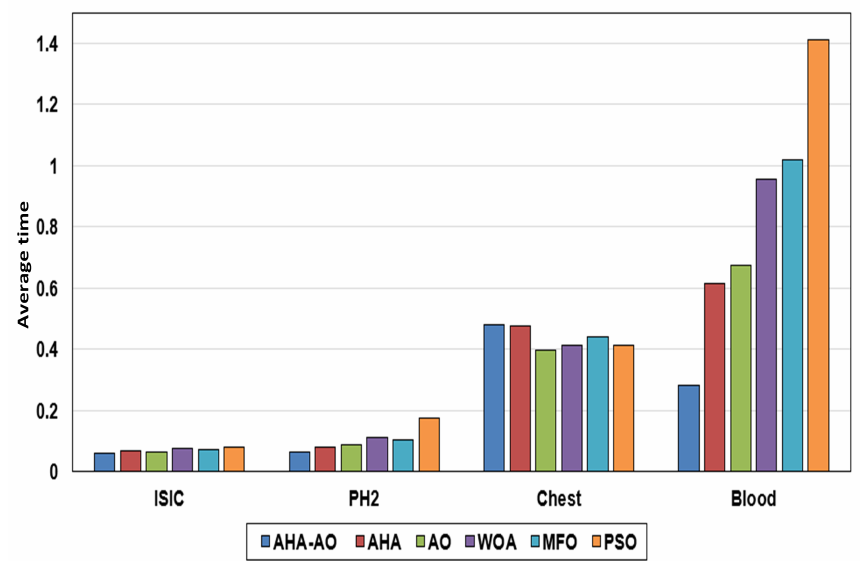
Figure 8. Comparison of the time taken by different optimizers on the four